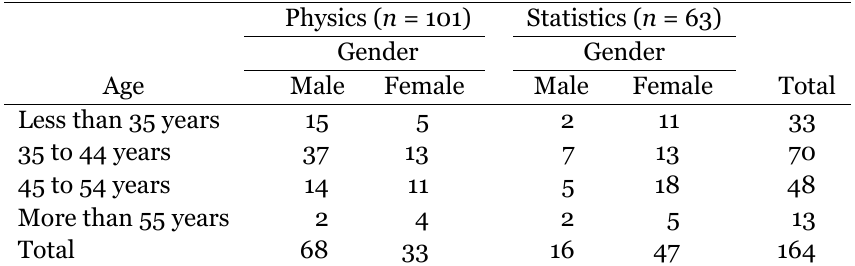
Characteristics of the Sample